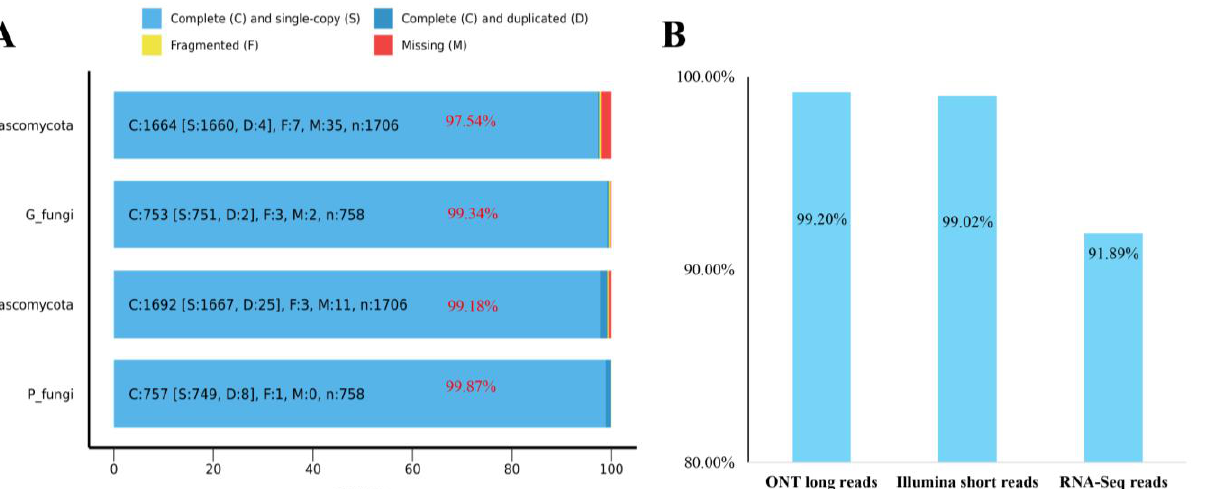
Table 2. Repeats Identified in Stagonospora Tainanensis Strain StFZ01.